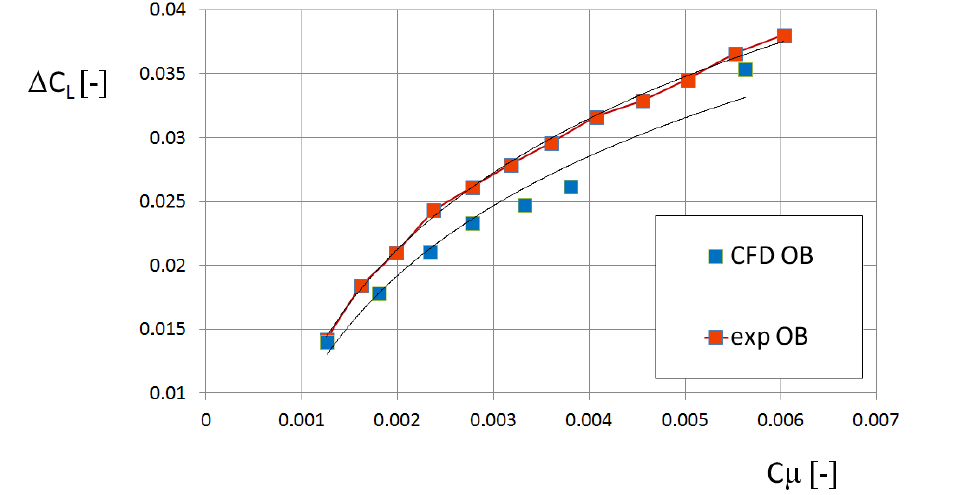
Figure 15. Comparison of the experimental data (see [21]), and the CFD results. Oscillatory blowing without suction. Black lines represent